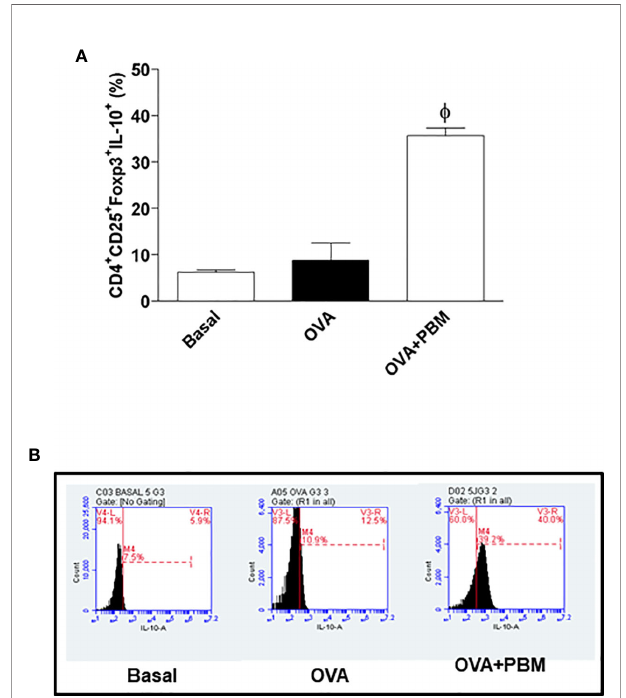
FIGURE 9 | EffectofphotobiomodulationonthepercentageofCD4+CD25+Foxp3 +IL-10+TregcellsinBALF. (A) CellswereexpressedinMFIandlivecellswere selectedandthenforwardversussidescatter(FSCvs.SSC)gatingwasusedto identifycellsofinterestbasedonsizeandgranularity(complexity).Thegatesstrategy wasused,wherethetotalcellpopulationinBALFwasselected,andthenCD4+T lymphocytes,CD25+,Foxp3+andIL-10+.Basalgroupn=5;OVAgroupn=7;PBM groupn=5;OVA+PBMn=8.Twoindependentsetsofexperimentswerecarriedout. Thehistogramsrepresenttheallgroupsevaluated (B) .Datarepresentmean± standarderror(SEM). f